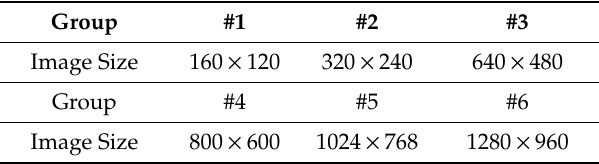
Table 2. Six groups of images with various